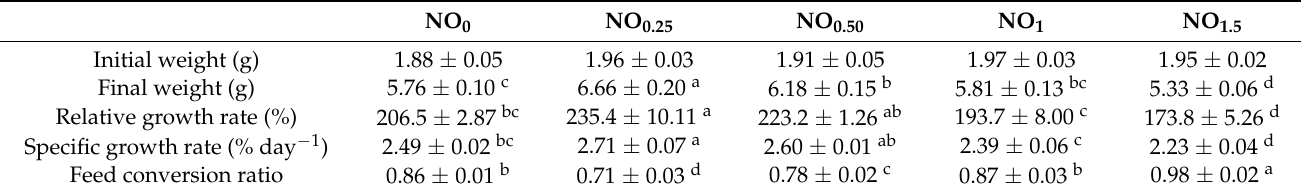
Table 4. Growth performance of common carp fed for 60 days with experimental diets supplemented with different percentages of neroli oli (NO).